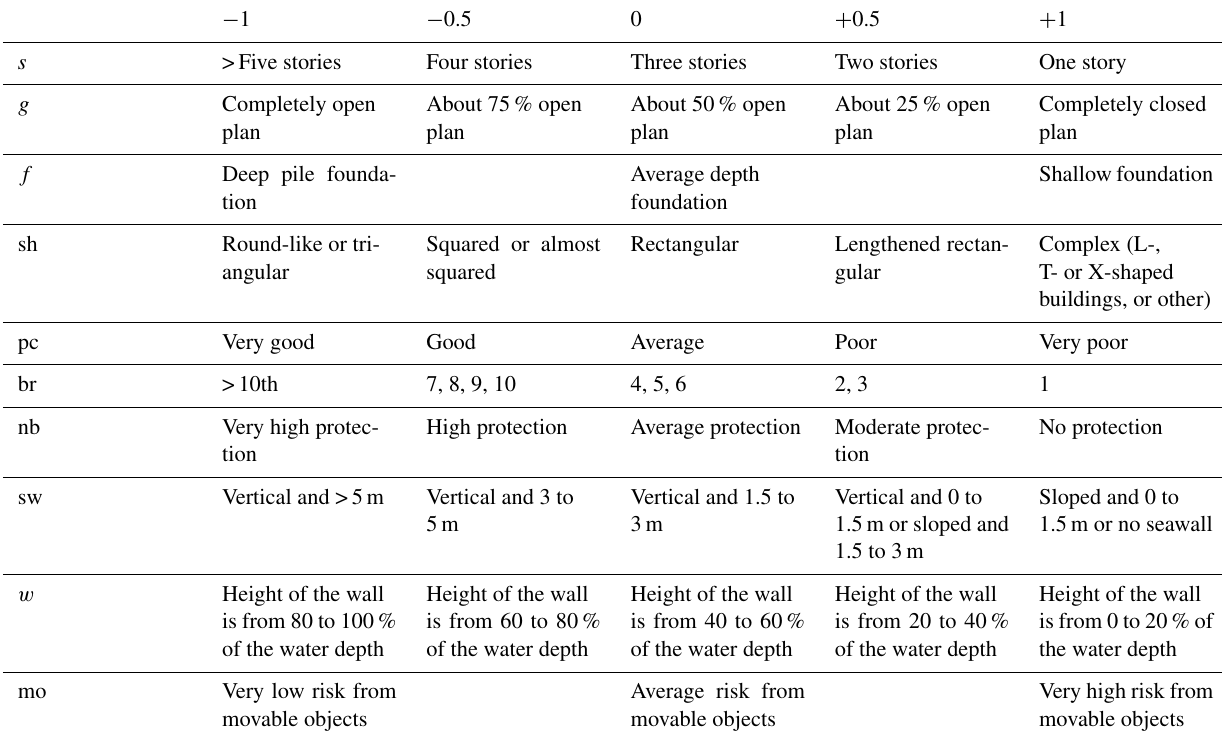
Table 4. Attributes and their values influencing the structural vulnerability of a building (Bv) and its surroundings characteristics (Surr) in PTVA-4 model (Dall’Osso et al., 2016).